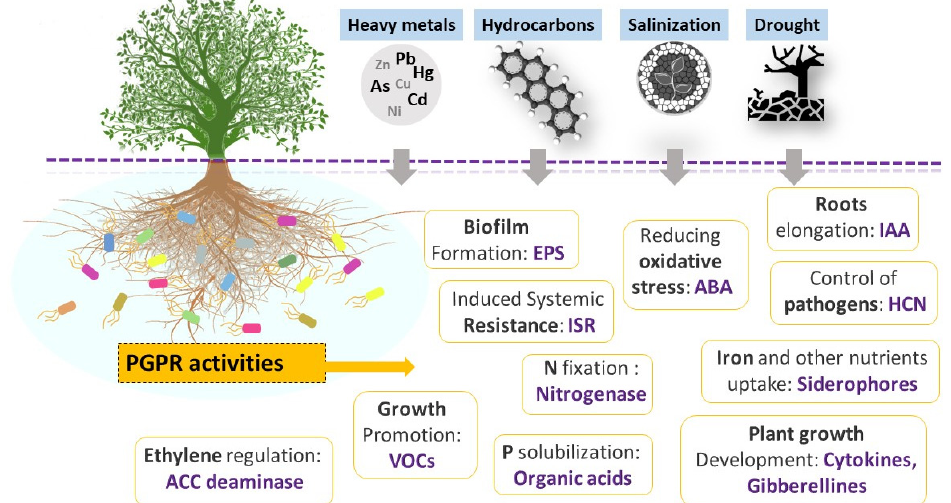
Figure 1. The sophisticated and efficient network of functional interactions created by PGPR to support plants’ health and performances in response to adverse environmental conditions and abiotic stresses. Abbreviations: EPS (exopolysaccarides); ABA (abscisic acid); IAA (indol2-3-acetic acid); HCN (hydrogen cyanide); VOCs (volatile organic compounds); ACC (1-aminocyclopropane-1- carboxylic